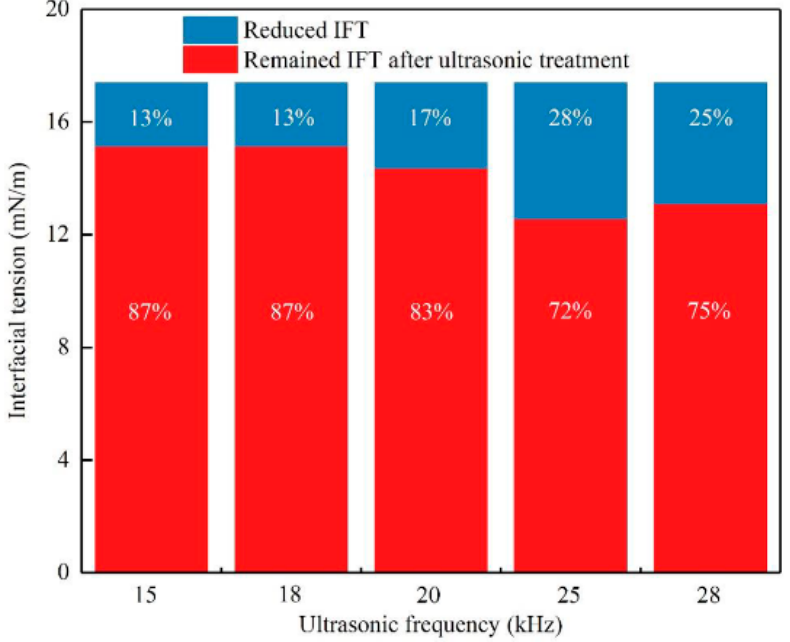
Figure 2. How different frequencies of ultrasonic waves affect the lowering of interfacial ten- sion (Reprinted from Li et al. [9] Copyright 2020, under the CC BY-NC-ND license, http:// creativecommons.org/licenses/by-nc-nd/4.0/, (accessed on 9 June